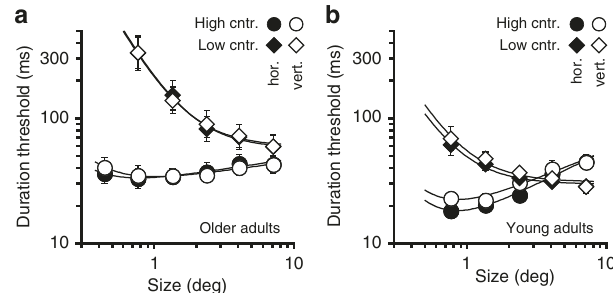
Fig. 5 Effects of size and contrast on spatial summation and surround suppression in older adults. a Pre-training data for older adults. The results revealed spatial summation at low contrast and weak spatial suppression at high contrast, with no differences between horizontal and vertical motions. Data were fi t with the model described in the “ Methods ” section. b Data for young adults shown for comparison purposes. All error bars